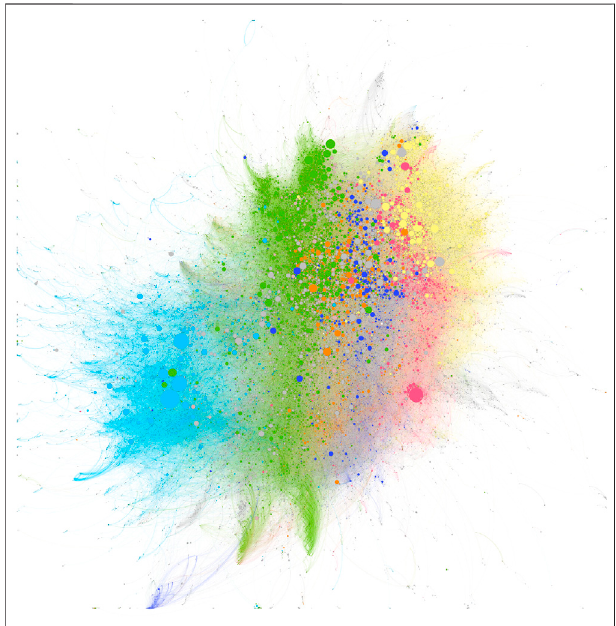
FIGURE 11 | As Figure 10 but with researchers colored by country of current af fi liated institution. China (light blue), US (green), United Kingdom (orange), Germany (dark blue), France (pink), and Italy